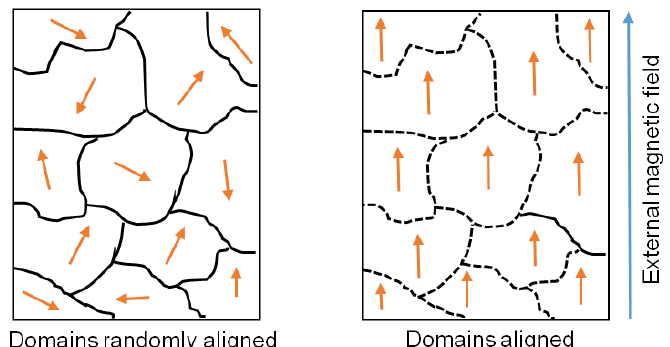
Figure 3. Schematic representation of ferromagnetic domains in absence ( left ) and in presence ( right ) of an external magnetic field applied. In the latter case, boundaries are dashed since when domains are aligned (right panel), the sample reaches the saturation point and there are not any domains walls.